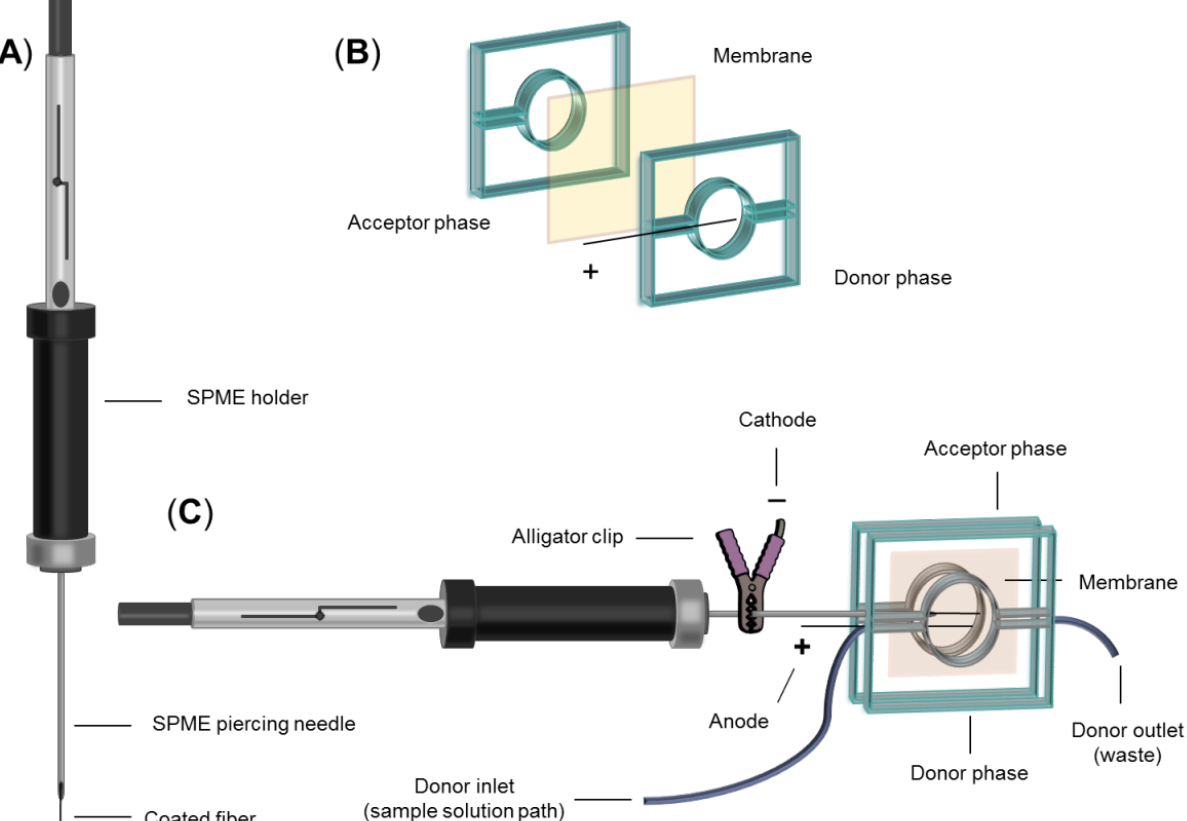
Figure 2. ( A ) Schematic of the SPME holder containing coated fiber; ( B ) schematic of the employed microfluidic device; and ( C ) assembled setup for on-chip EM-SPME.